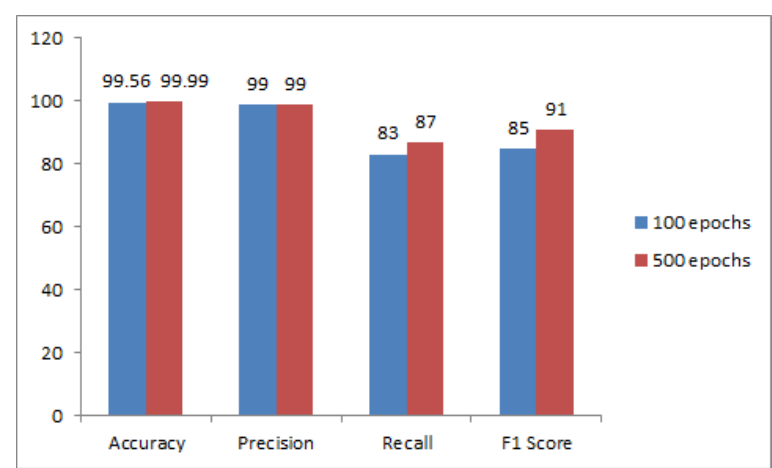
Figure 9. Receiver operating characteristics curve for 500 epochs.